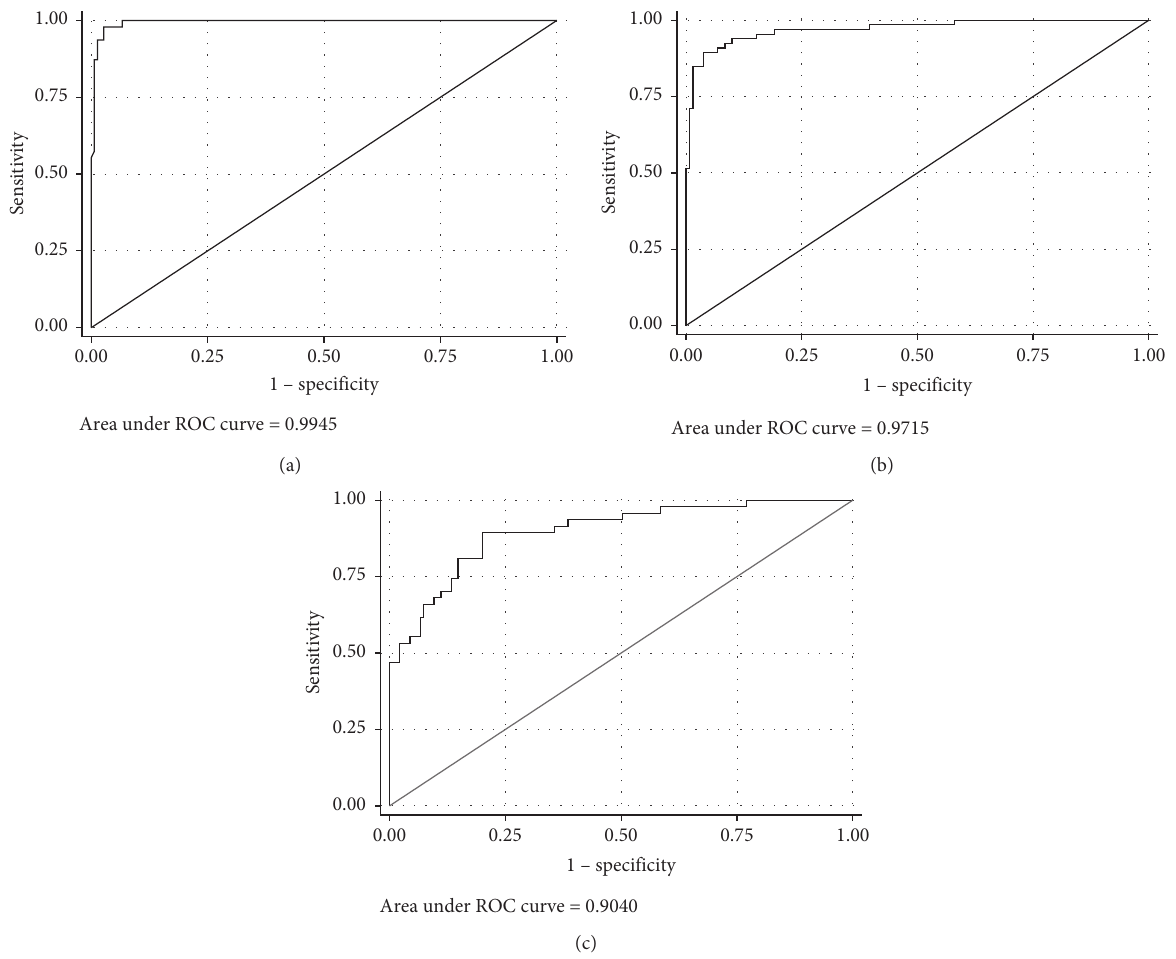
Figure 3: Receiver operating characteristic (ROC) curves for the diagnosis of acidosis, hypercapnia, and hyperlactatemia according to capillary samples. (a) Acidosis ROC curve (area under ROC curve � 0.9945). (b) Hypercapnia ROC curve (area under ROC curve � 0.9715). (c) Hyperlactatemia ROC curve (area under ROC curve �